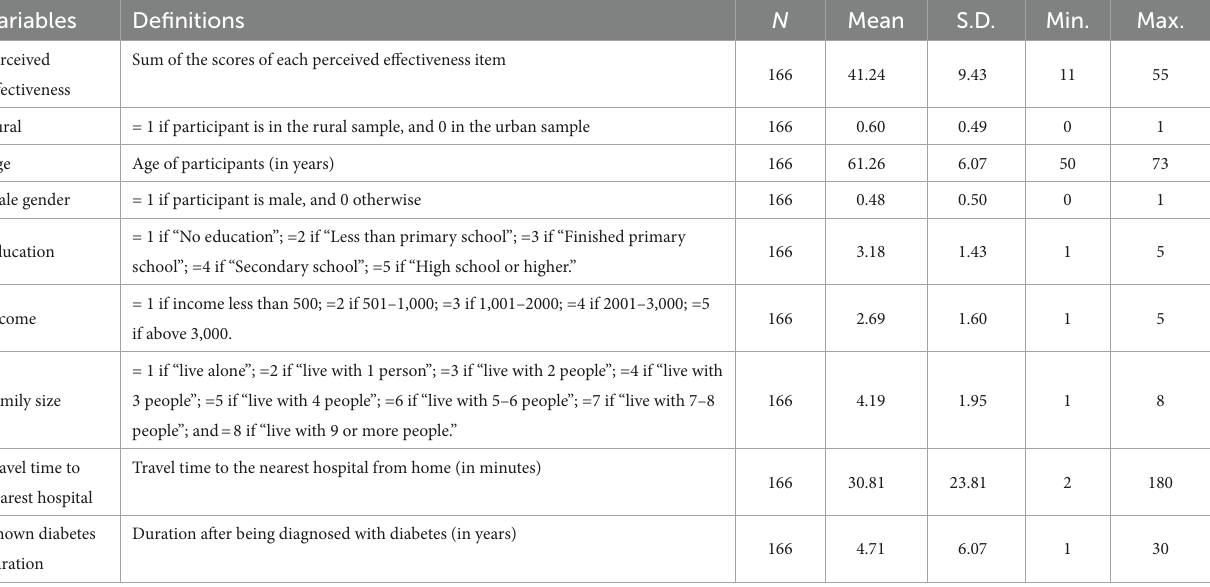
TABLE 1 Descriptive statistics of